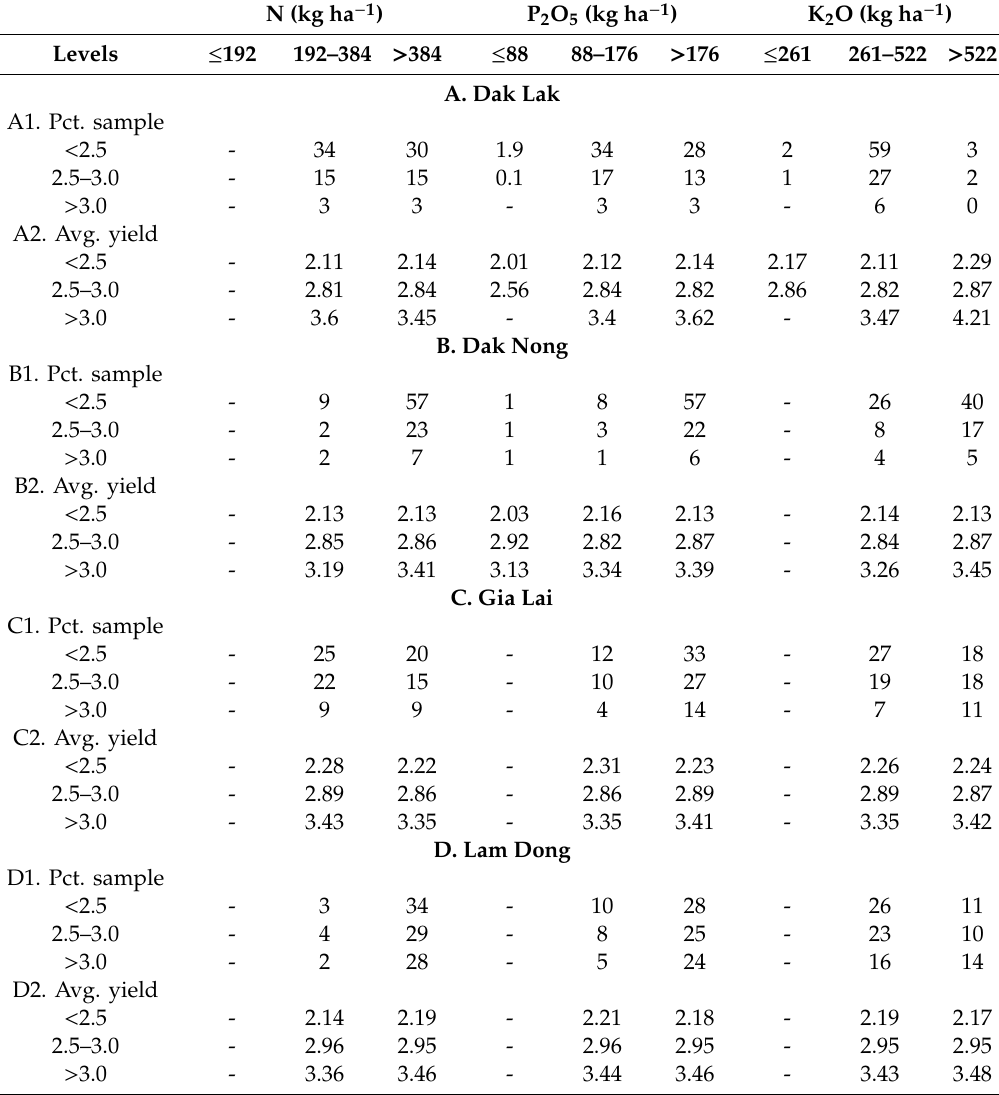
Table 7. Variations of Robusta co ff ee yields under di ff erent categories of N, P 2 O 5 and K 2 O rates in small-scale farms for each of the study provinces in Vietnam. Pct. sample: sample distribution from all the 2008–2017 dataset (expressed in %); Avg. yield: average co ff ee yield (ton ha − 1